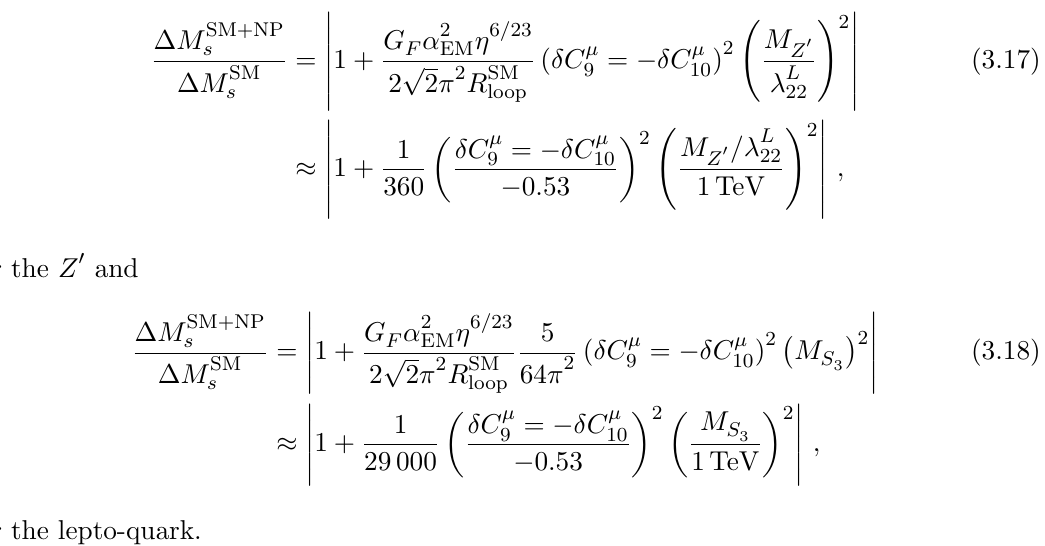
Figure 5 . We show the predicted new physics e(cid:11)ects (cid:1) M NP (cid:14)C (cid:22) = (cid:0) (cid:14)C (cid:22) in comparison with the allowed two-sigma regions (shaded) in the FLAG ’19, Avg. ’19 9 10 and Future ’25 scenarios. The left and right panel assume the simpli(cid:12)ed Z 0 model and scalar lepto- quark model, respectively. Hatched regions show limits from neutrino trident production or direct LHC searches and perturbative